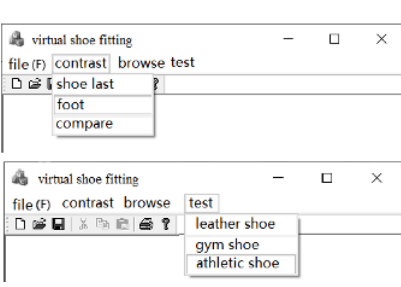
Fig. 19. Data query window.